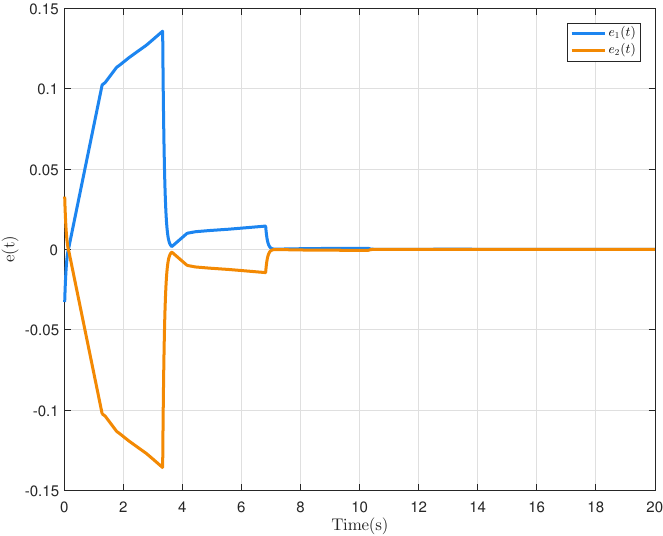
Figure 1. State responses of the error